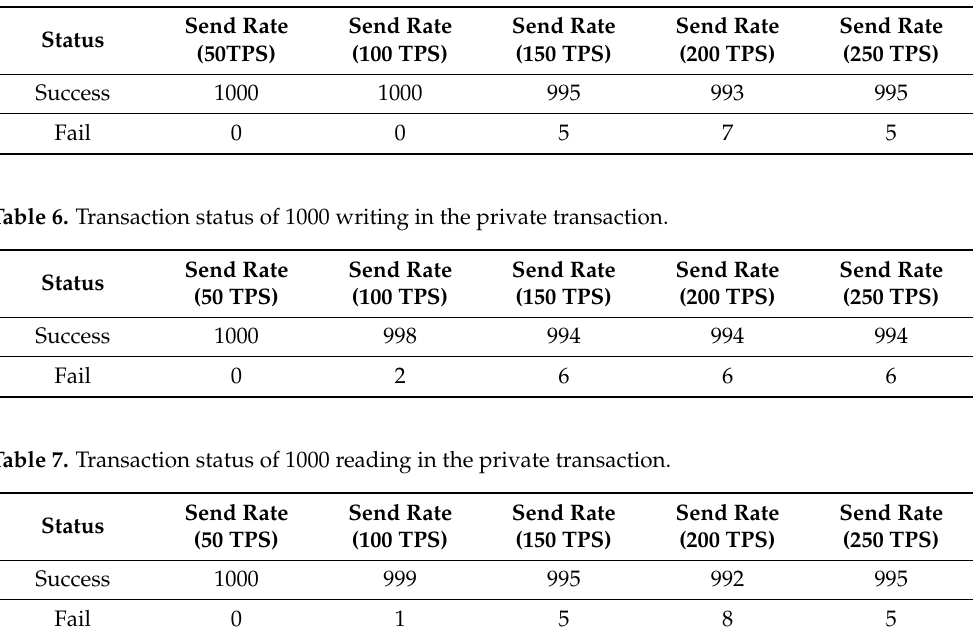
Table 5. Transaction status of 1000 reading in the common transaction.